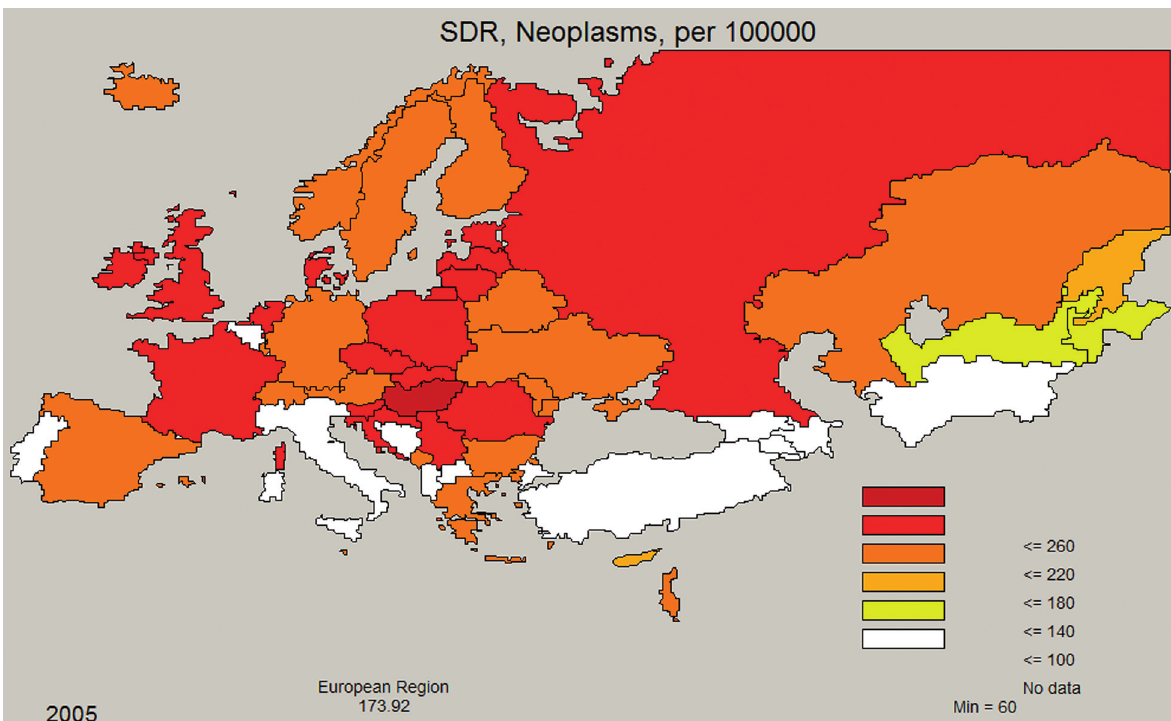
Fig. 4. Legend deformed in Mozilla Firefox 3.6 web browser. The same deformation is observed in the Opera 11 web browser (WHO/Europe EMDB